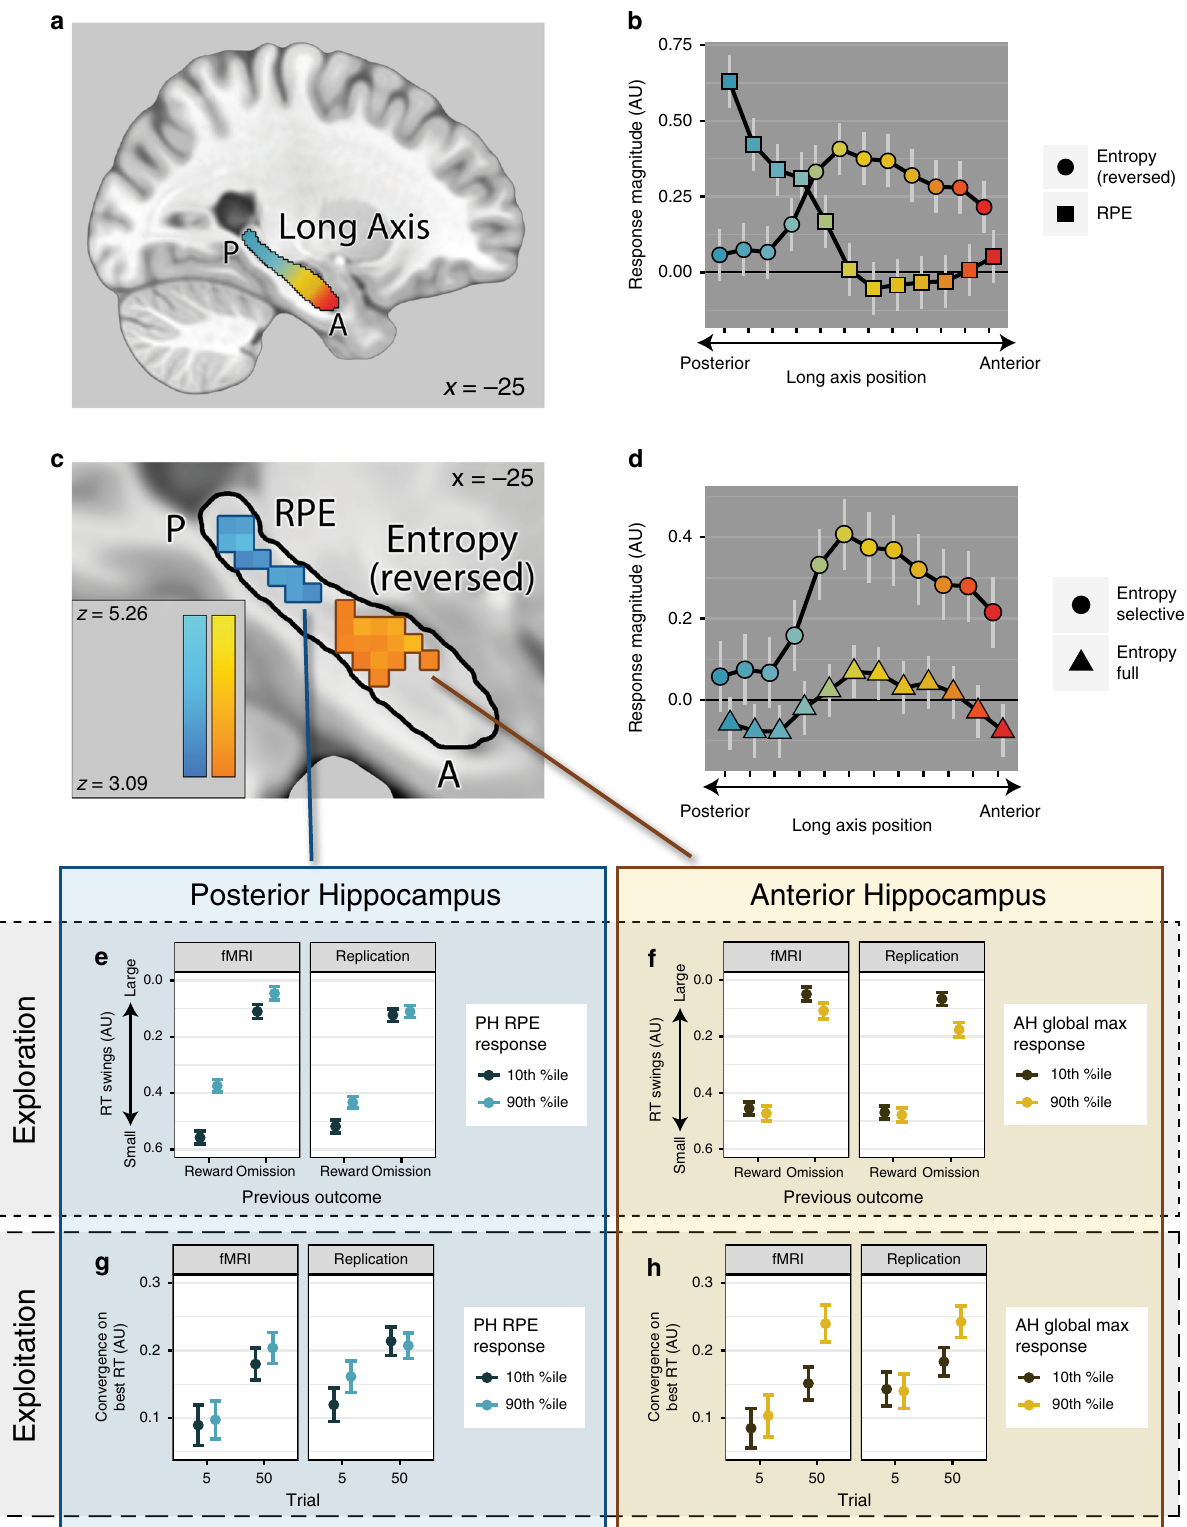
p = 0.021, Fig. 2h), particularly late in learning ( − 1/trial × RT Vmax